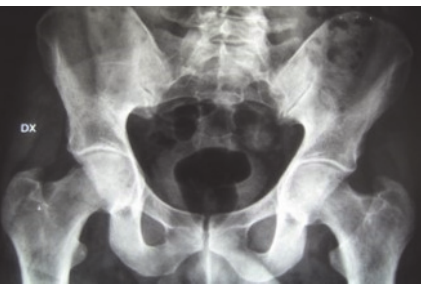
Figure 4: AP X-ray of the pelvis detects acetabular protrusion in a 36-year-old patient affected by Marfan syndrome. The patient complained of hip pain and clinicalexamination showed a restricted range of motion of the hips.